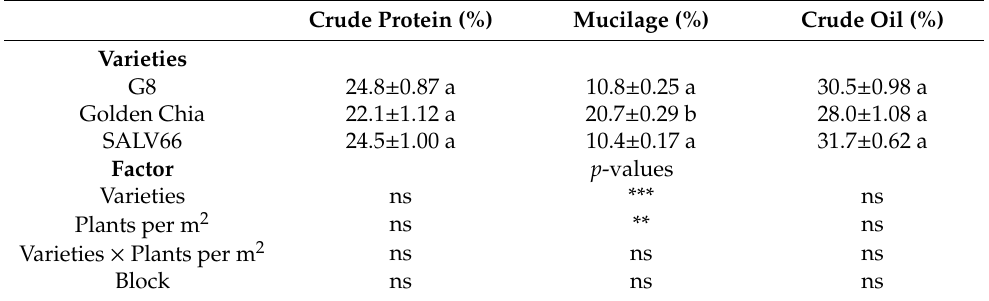
Table 6. Protein, mucilage, and oil content (expressed as a percentage) of three chia varieties (G8, Golden Chia, SALV66) cultivated at Ihinger Hof in 2018 ( n = 3, α = 0.05, mean ± standard error). Crude Protein (%)